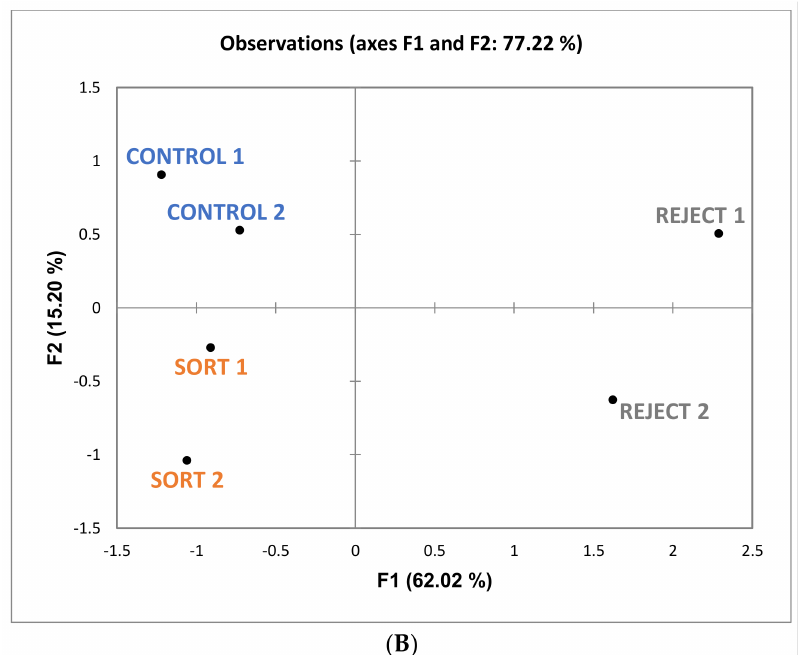
Figure 9. Loadings ( A ) and score ( B ) plots of a multiple factor analysis (MFA) between volatile compounds (blue) in Cabernet Sauvignon wines that differed significantly, and all sensory attributes (red) generated from the respective descriptive analysis panel. Only biological replications consistent with those for sensory were included in the